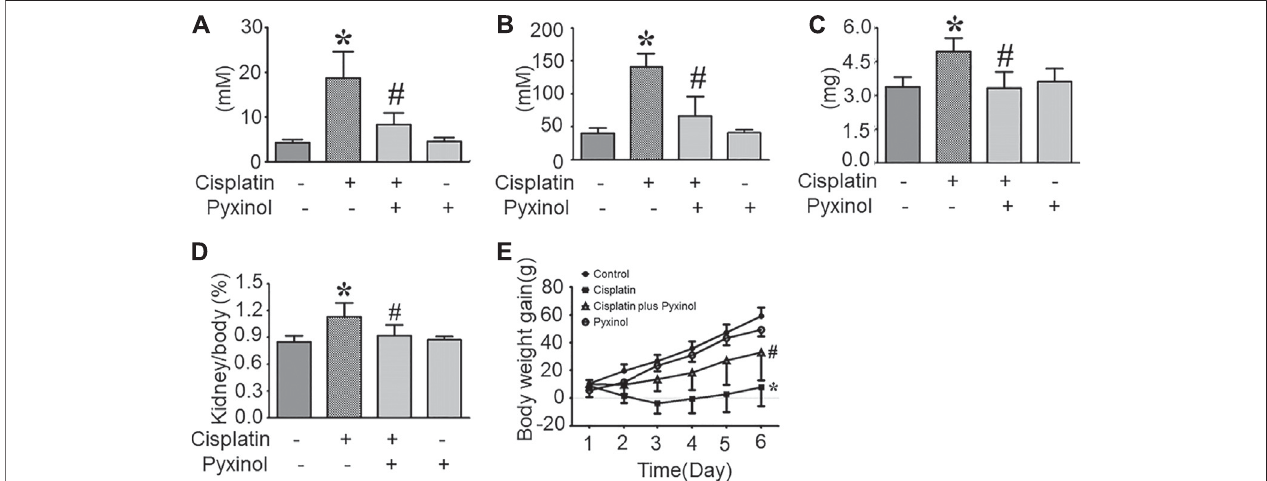
FIGURE 2 | Effects of pyxinol on the levels of BUN and Cre in cisplatin-treated rats. (A) plasma BUN level; (B) plasma Cre level; (C) Total 24-h urinary protein; (D) Kidney body ratio; (E) Body weight gain. All data were expressed as means ± SD ( n (cid:1) 6). *p < 0.05, compared with the control group; #p < 0.05, compared with the cisplatin group.